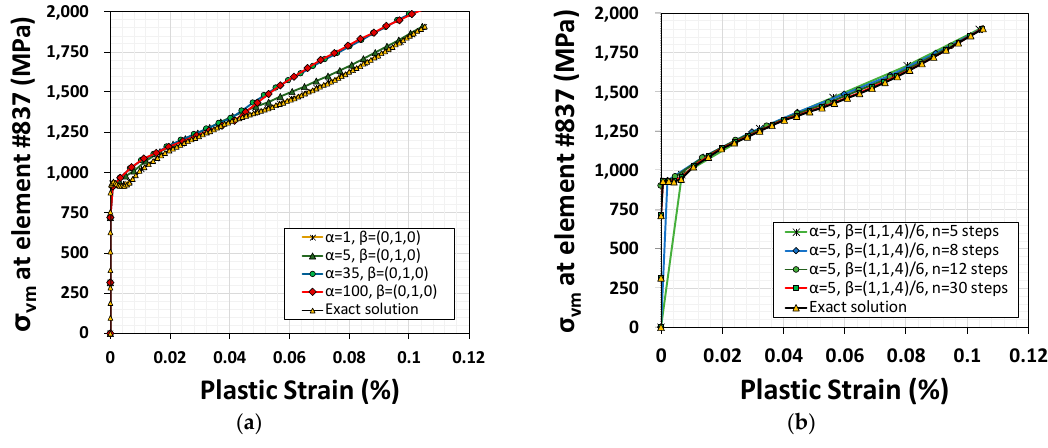
Figure 14. Validation for quadratic α -method using von Mises stress at the element #837: ( a ) varies from 1 to 100, while is kept constant as {0,1,0}, ( b ) time steps varies from 5 to 30, while and are kept constants as 5 and {1,1,4}/6, respectively